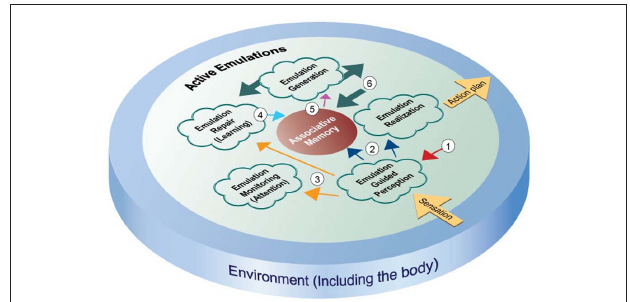
Figure 1 | This figure depicts an emulation-based framework for cognition. The constituent control processes that make up the framework create and operate on emulations. The control processes are described in detail in the manuscript text. The figure shows the control processes operating in a pool of active emulations. Thick arrows represent the movement of emulations out from the emulation generation process into the active pool. The meanings of the numbered arrows are given below. (1) Sensory expectations – the red arrow depicts expectations in active emulations that are fed back to lower-level sensory regions, creating a bias in those regions to quickly interpret incoming sensory information in accordance with expectations. (2) Sensory percepts – the purple arrows show how perception affects associative memory and emulation realization. Perceptions of the current environmental state influence the advancement of active emulations, and trigger associations that can generate new emulations. (3) Difference signals – the yellow arrows indicate the use of difference signals in attention and learning. When incoming sensory information differs from the expectations in emulations, difference signals are generated that can trigger increased attention to the unexpected sensations, and reinforcement learning activity to accommodate the new information. (4) Reinforcement learning – the blue arrow depicts the action of learning signals that update associative memory so that future expectations will take current information into account. (5) Actions and associated environmental predictions – the pink arrow indicates the flow of associations used by emulation generation. Action plans and predictions that make up emulations are derived from associations generated by either real or emulated sensory states. (6) Emulation chaining – the thick arrow shows active emulations as input to associative memory. The expected future environment of emulations can trigger associations that generate new emulations, causing chains of emulations